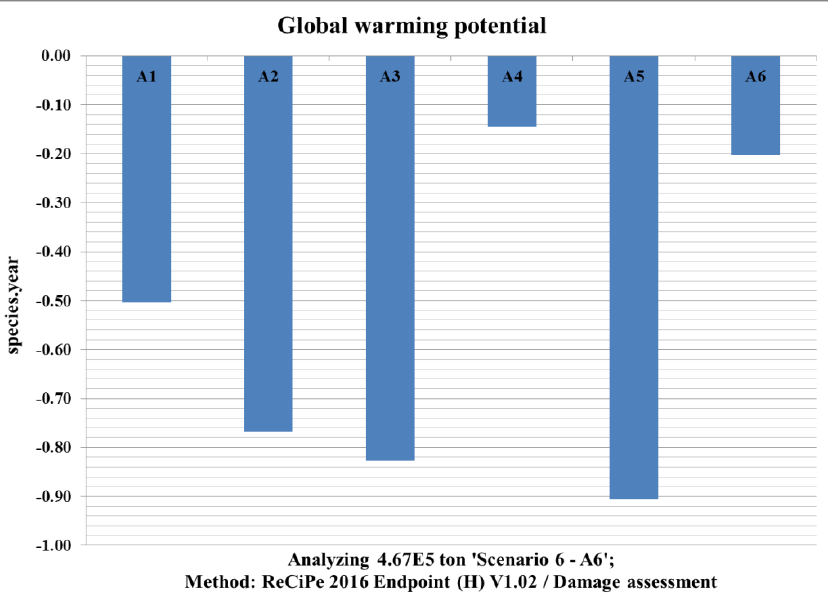
Figure 6. Global warming impact potentials.